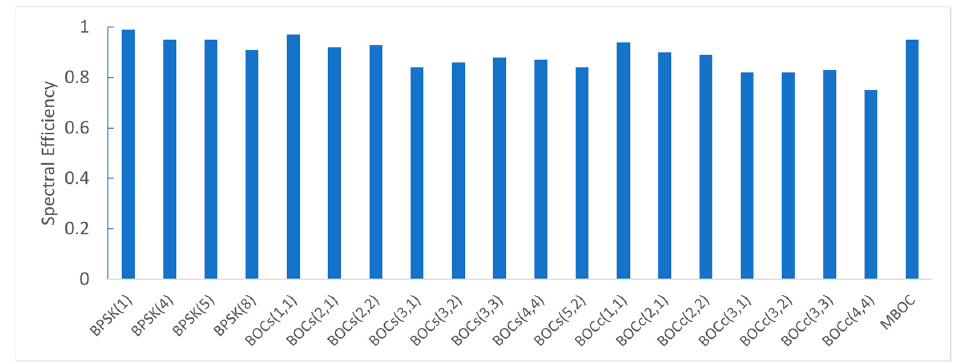
Figure 9. The spectral efficiency for each candidate.